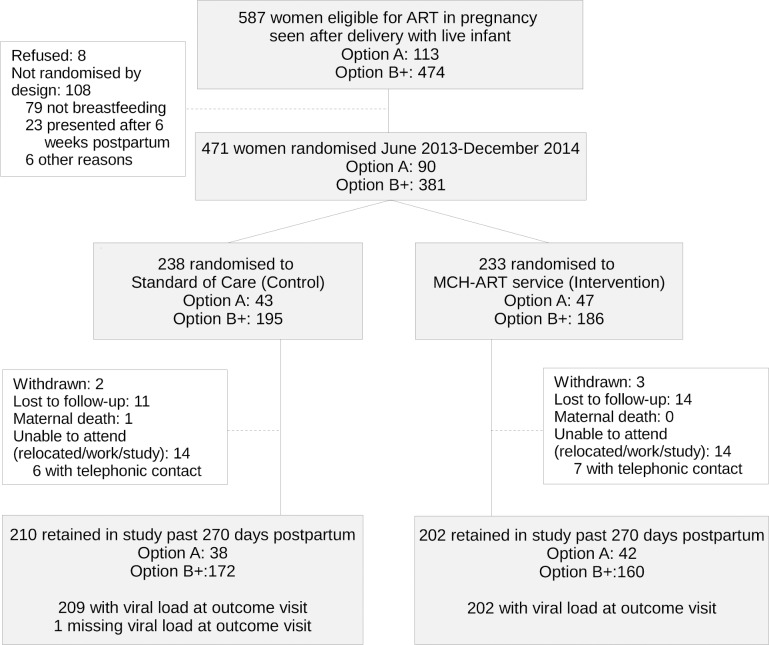
Study enrolment, randomisation, and follow-up.